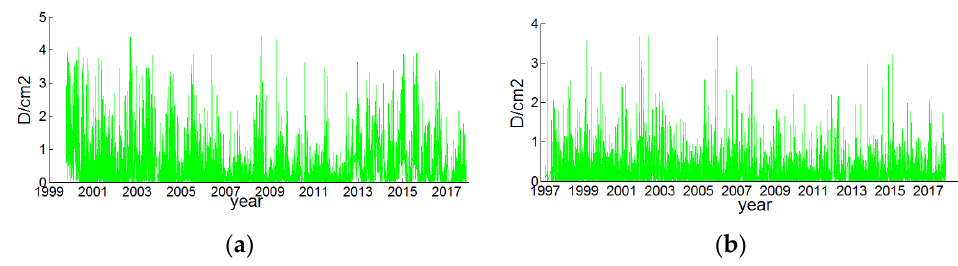
Figure 8. Residual squared sequence of elevations of two CORS stations, ( a ) bjfs and ( b ) bogo.